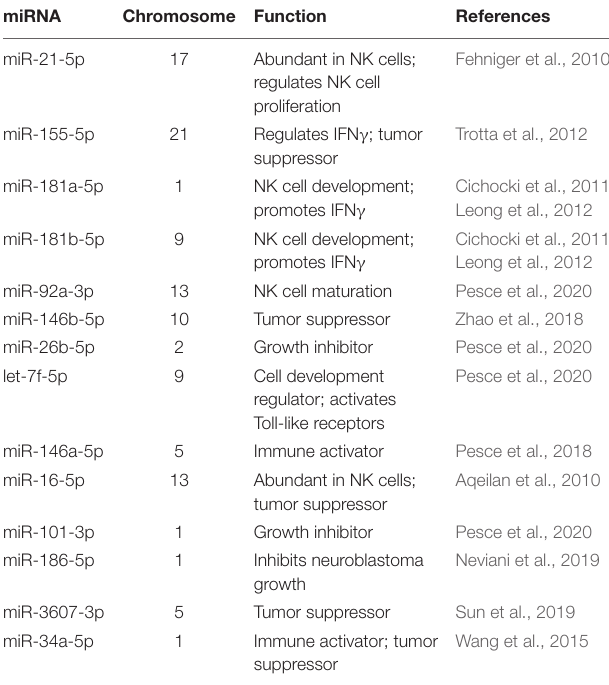
TABLE 1 | Proteomic analysis of NK3.3-derived EVs listed by abundance. Protein